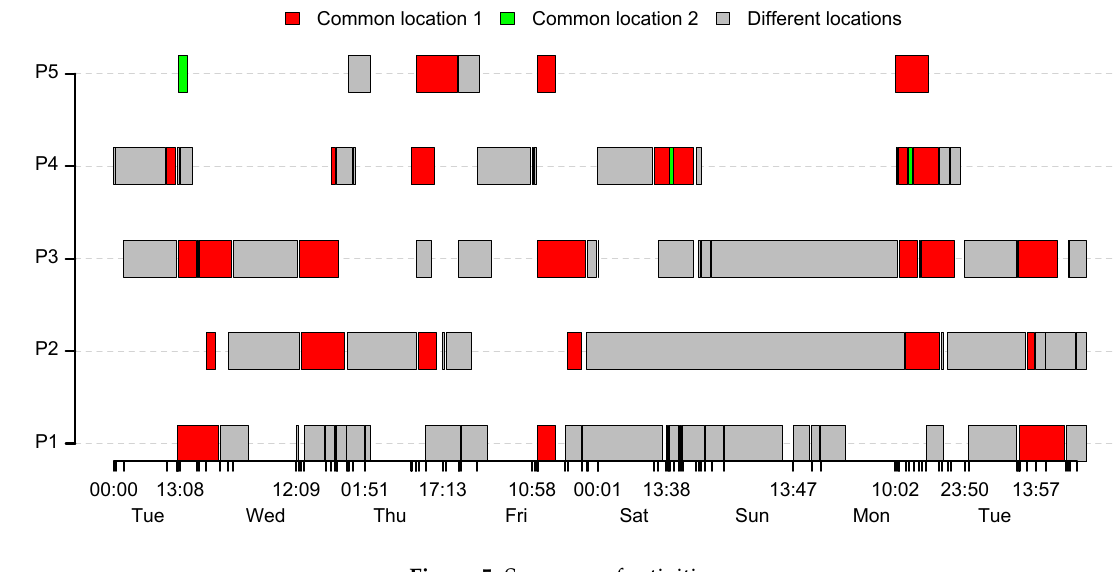
Figure 5. Sequence of activities.